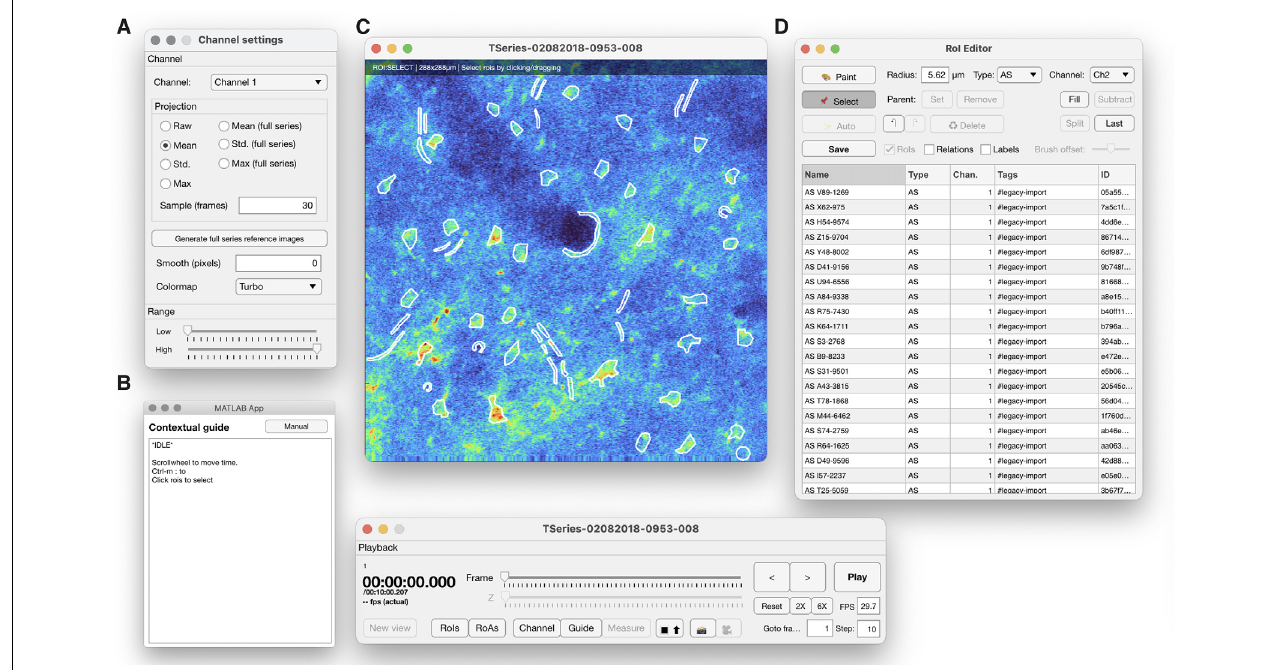
FIGURE 4 | The ROI manager provided in Begonia comprises the following features: (A) a view controller that determines what and how imaging data should be displayed, (B) a contextual guide window that informs the user of useful shortcuts and keyboard commands for the current mode. (C) The main image window, where raw imaging data or running averages or various projections of the imaging data can be displayed. Manually segmented ROIs are drawn into the overlay. (D) An ROI editor that organizes the ROIs and enables the user to classify, rename, delete or modify